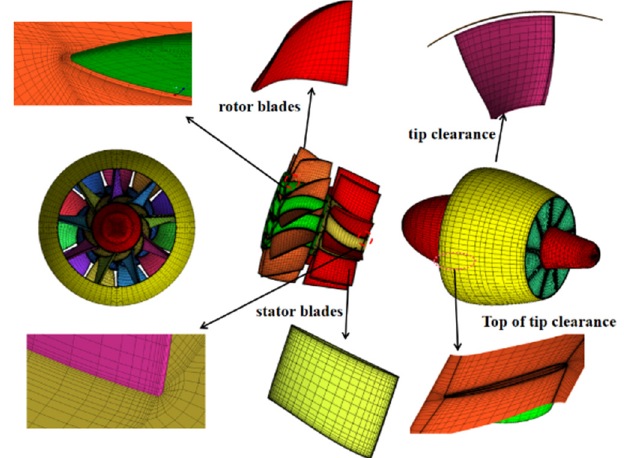
Figure 4. The detailed full structure grid of the PJP.